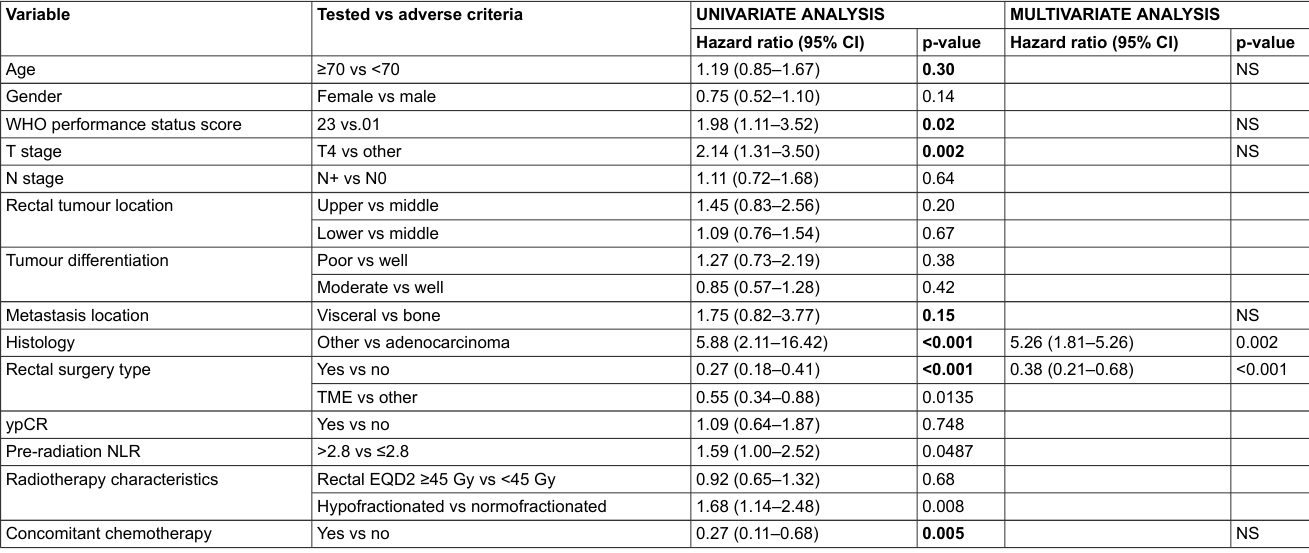
Table 3: Predictive factors for progression-free survival in the whole set of patients (n = 148). Variable